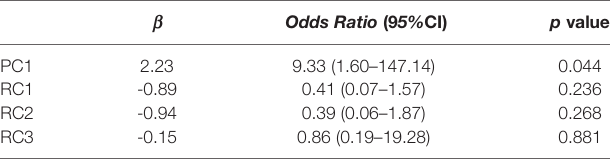
TABLE 3 | Combined cytokines associated with remission from NMOSD attacks at 1-month visit.